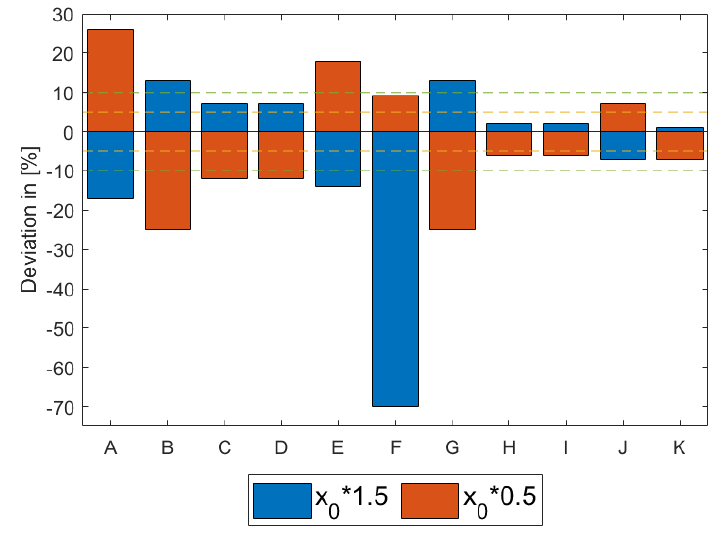
Figure 6. Influence of material parameter on current density. Raw values are from the work in [140]. With the capital letters representing the following material